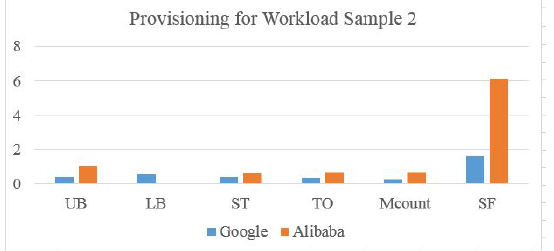
Figure 17. Scaling Ratios for Google and Alibaba Workload Type 2.